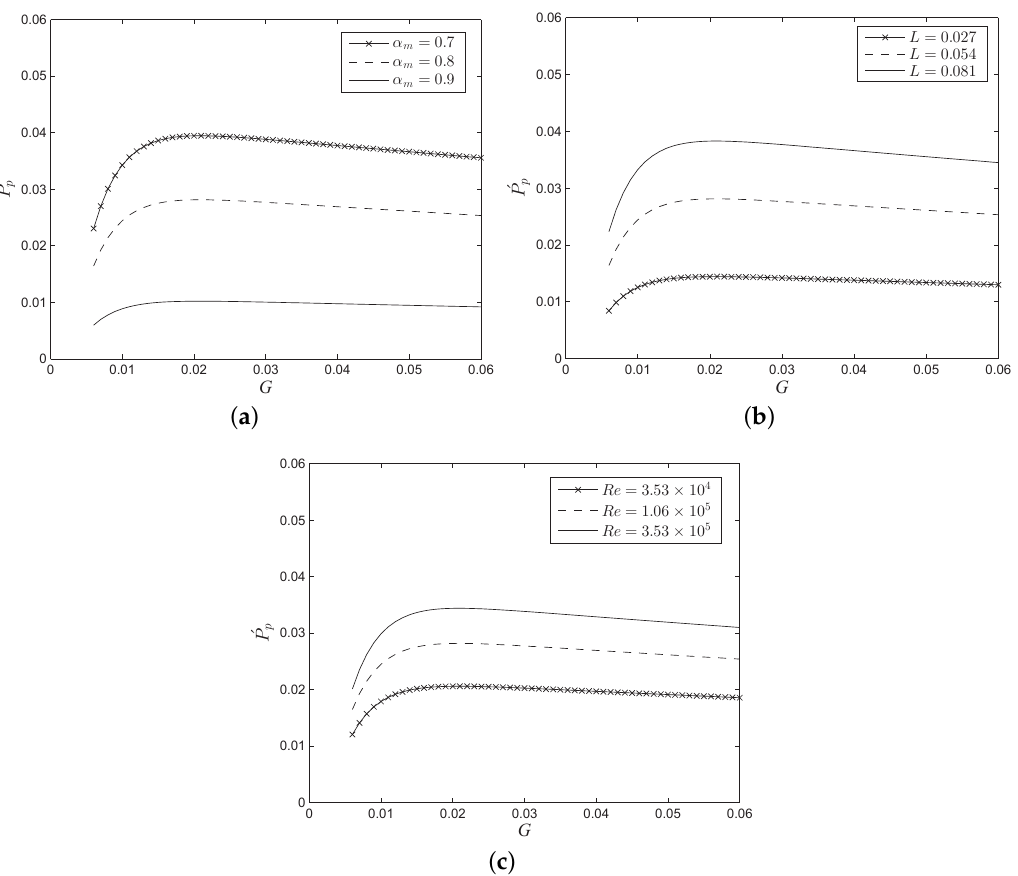
Figure 11. Variations of the dimensionless pressure power, ´ P p , versus G for sum of side surfaces of the magnet (“ magnet left ” and “ magnet right ”) at different values of ( a ) magnet angle ratio; ( b ) magnet thickness ratio; and ( c ) rotational Reynolds